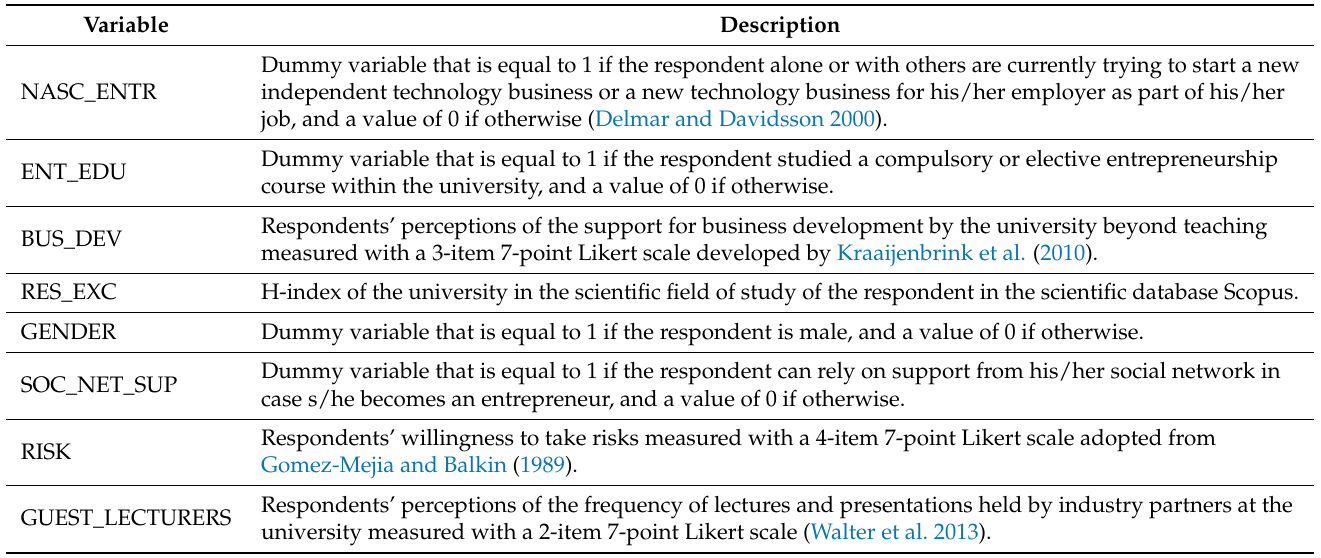
Table 2. Definition of the variables used in the